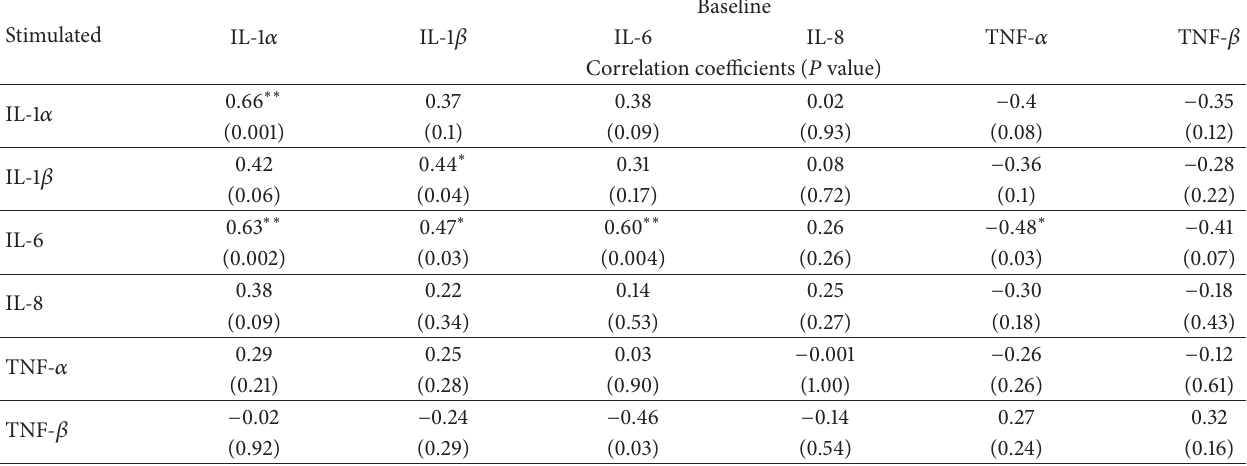
Table 4: Correlation between baseline and stimulated salivary proinflammatory cytokines in patients with periodontitis. Stimulated